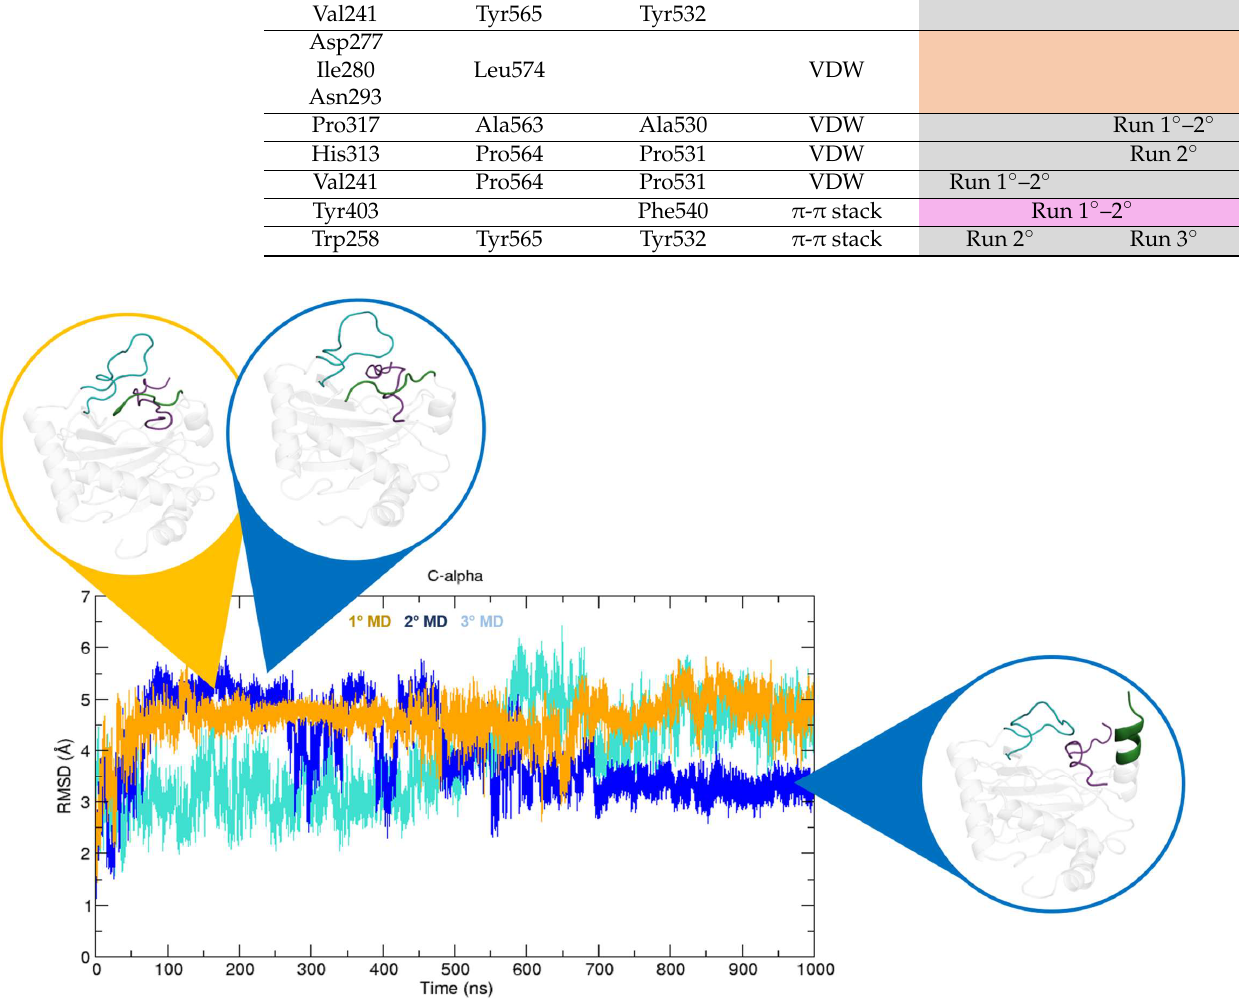
Figure 3. RMSD and RMSF plots calculated on PHD2/HIF-1α and PHD2/HIF-2 α complexes C-alpha over time. ( A ) RMSD (left) and RMSF (right) of the PHD2/HIF-1α complex. The four simulations that were run are shown in different colors: the first (orange), the second (blue), the third (turquoise), and the fourth (green). ( B ) RMSD (left) and RMSF (right) plots of the PHD2/HIF-2α complex. The first simulation is indicated in orange, the second in blue, and the third in turquoise.